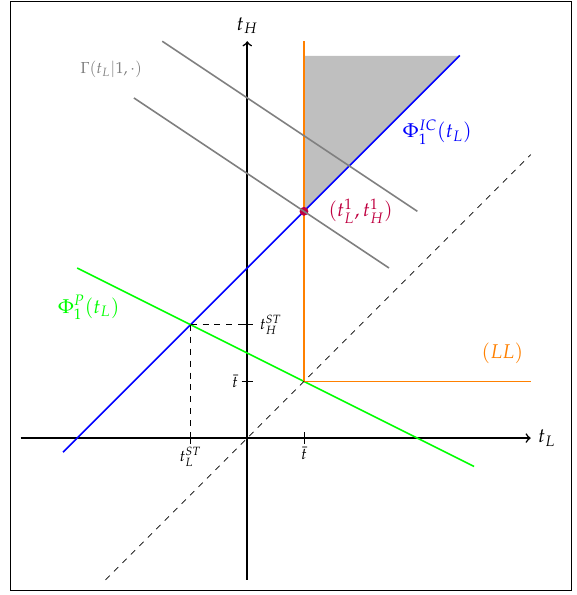
Figure 1. e = 1 and ¯ t ≥ t ST